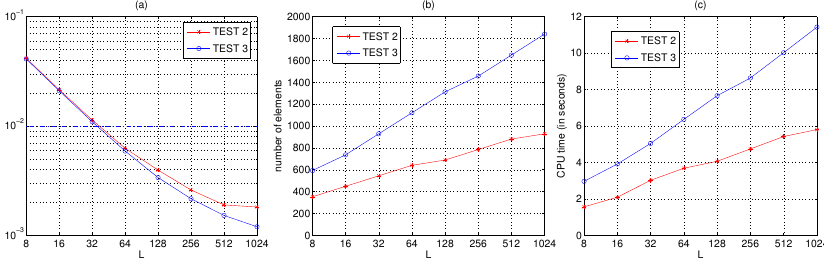
Figure 6. TEST 2 and TEST 3 on hexahedron Mesh1 for a 10 × 10 contact grid. (a) Relative error at the origin for different domain sizes L . The dashed line indicates the target accuracy defined by equation (3.1). (b) Numbers of elements. (c) CPU time in